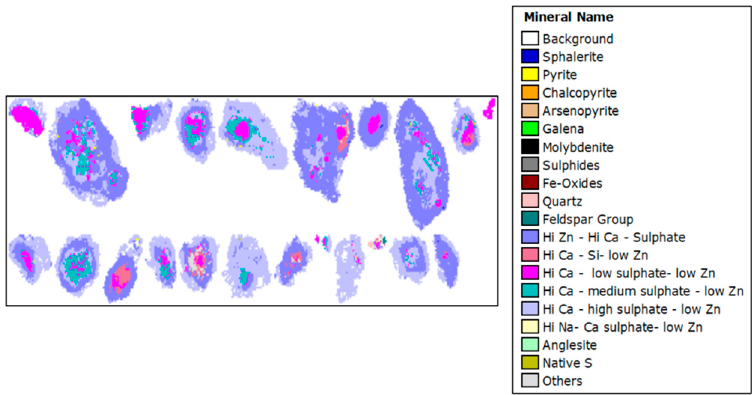
Figure 7. Nodular structures of solids exploratory test using CaO.